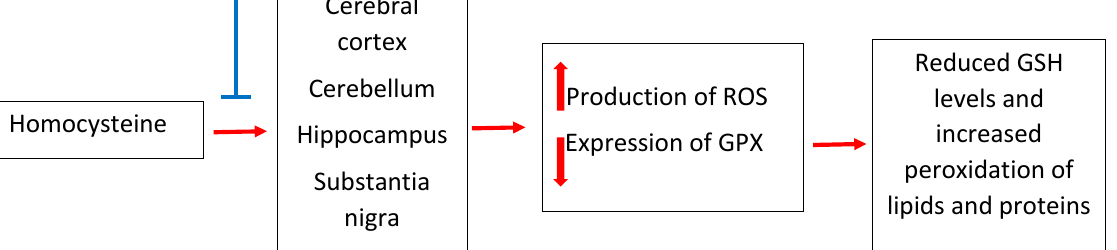
Figure 2. Melatonin inhibits the neurotoxicity of homocysteine. In regions of the brain particularly sensitive to oxidative stress, homocysteine increases the synthesis of reactive oxygen species, which react more intensively with glutathione, leading to a reduction in the level of this endogenous antioxidant. In addition, a reduction of glutathione peroxidase expression does not allow for an effective reduction of lipid hydroperoxides and hydrogen peroxide. This results in oxidative damage to brain lipids and proteins, the accumulation of which can lead to clinical symptoms of Parkinson’s disease, Alzheimer’s disease, and fetal alcohol syndrome. Melatonin prevents these adverse homocysteine-induced changes by scavenging the reactive oxygen species induced by homocysteine and by direct positive regulation of glutathione peroxidase expression. GSH, glutathione; GPX, glutathione peroxidase; ROS, reactive oxygen species.